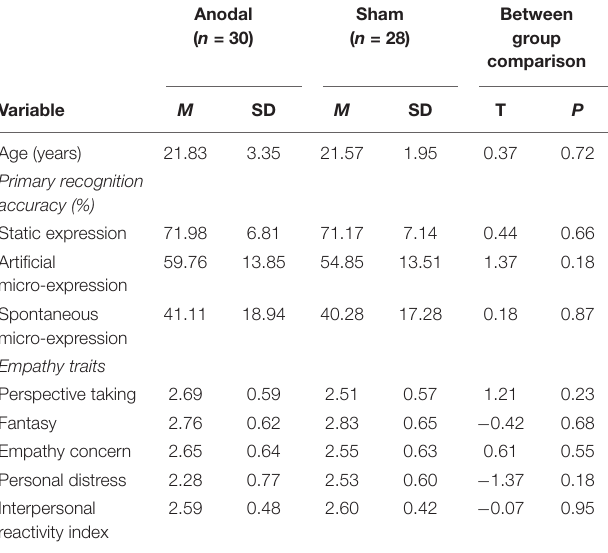
TABLE 1 | Characteristics of anodal and sham groups.